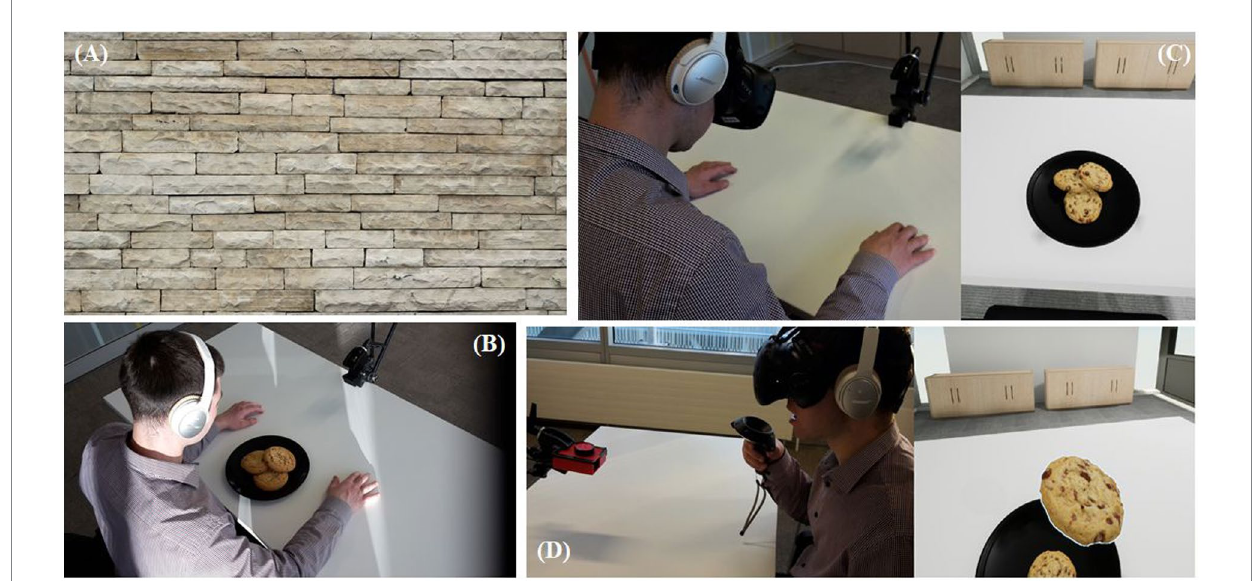
FIGURE 1 Experimental conditions and setup. (A) A user exposed to a white brick wall (NB condition). (B) A user exposed to real cookies (RC condition). (C) A user wearing head-mounted display and their view of the view of the virtual chocolate chip cookies in the virtual experiment room (VC condition). (D) A user exposed to virtual chocolate chip cookies with chocolate scent, holding a remote controller to interact with the virtual cookies